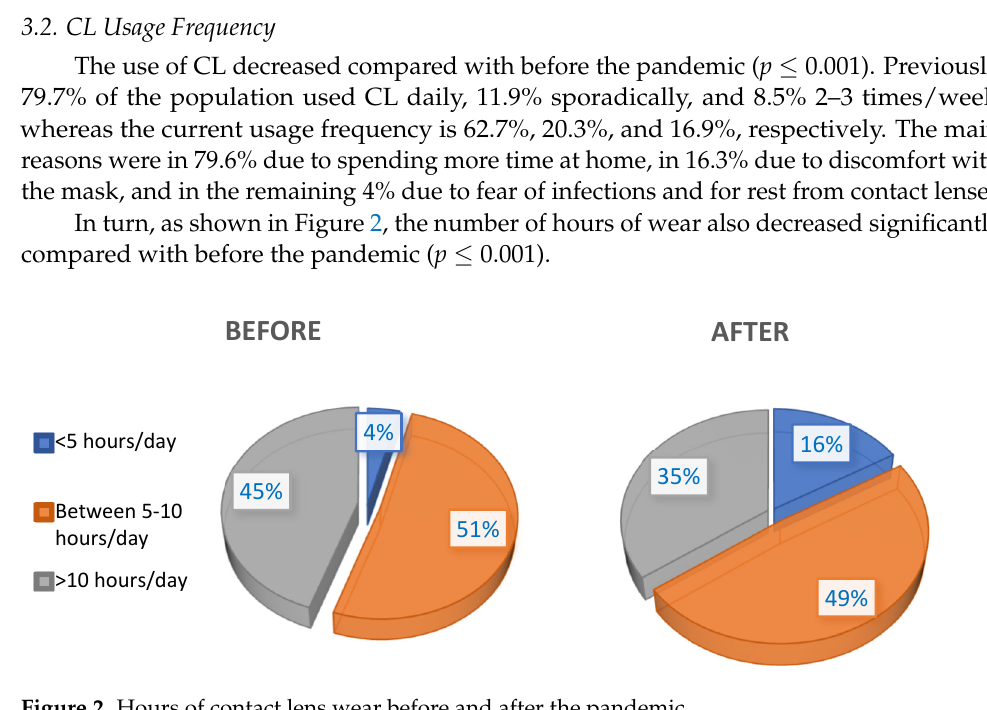
Figure 1. Spherical equivalent as a function of ametropia.